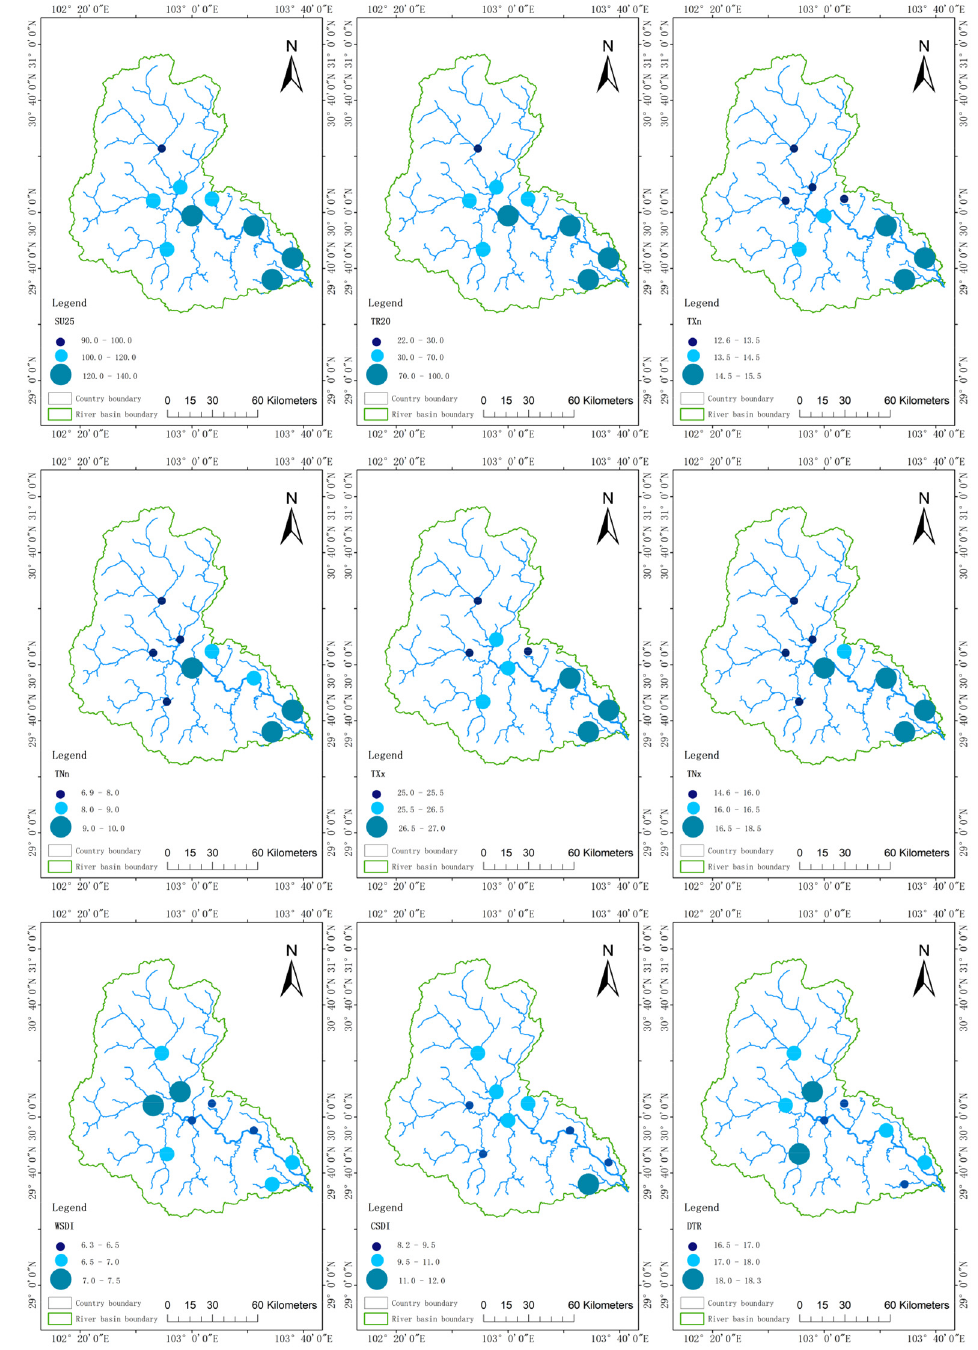
Figure 2. Spatial distribution of extreme temperature index in the Qingyi River basin from 1960 to 2020